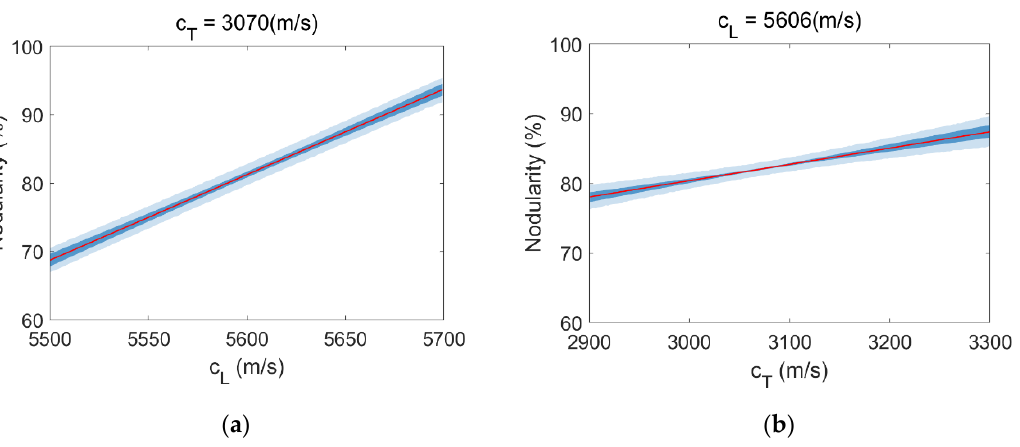
Figure 12. (Color Online) The best regression function and its associated 90% confidence bounds of hierarchical Bayesian regression model of Group #7 from the thirteenth week. ( a ) A cross-section at c T = 3070 m/s, and ( b ) a cross-section at c L = 5606 m/s. Table 3. The estimation results of validation specimens T-1 and T-2 using different methods.